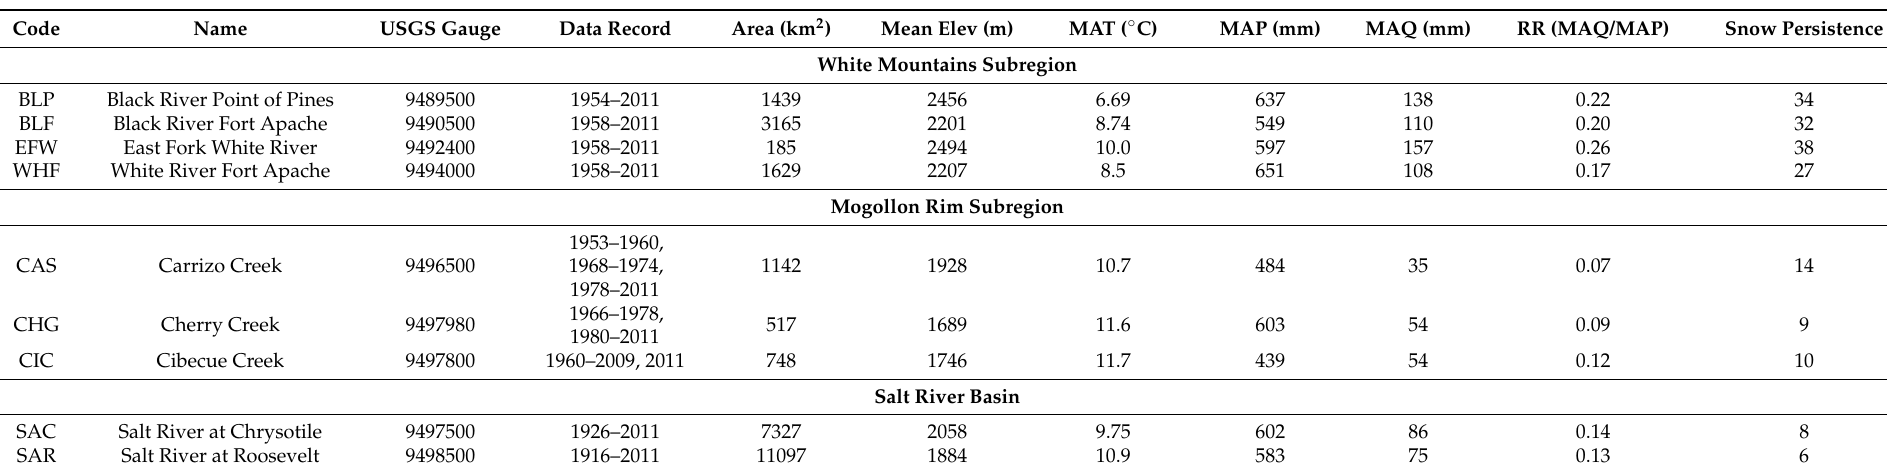
Table 1. Characteristics of basins within the Mogollon Rim and White Mountain sub-regions and the Salt River basin 1